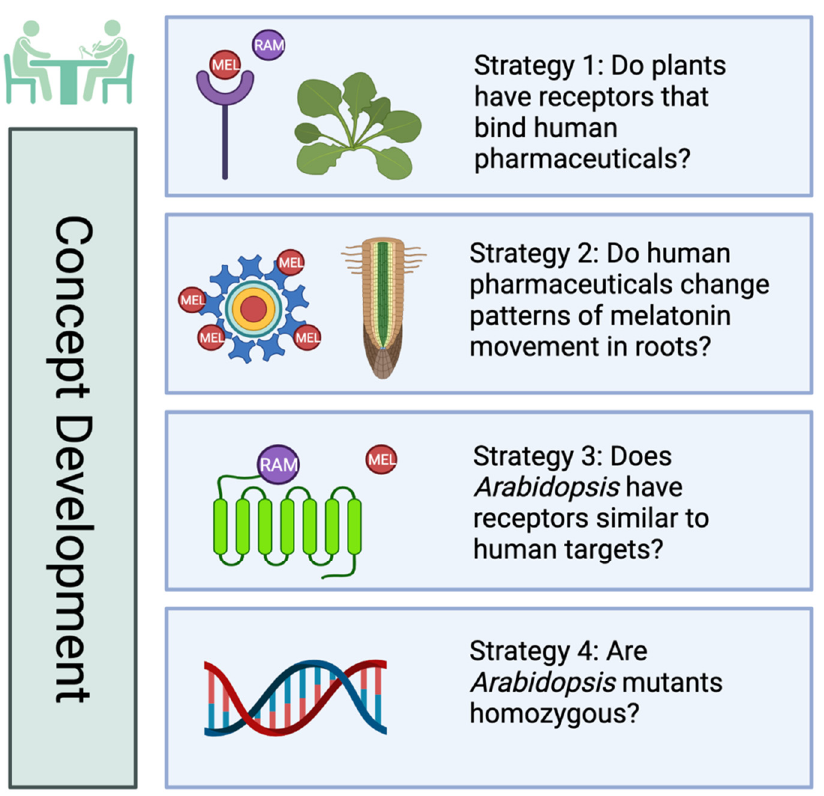
Figure 1. Overview scheme of the experiments included in the study. This image was created in www.biorender.io (accessed on 22 June 2022).